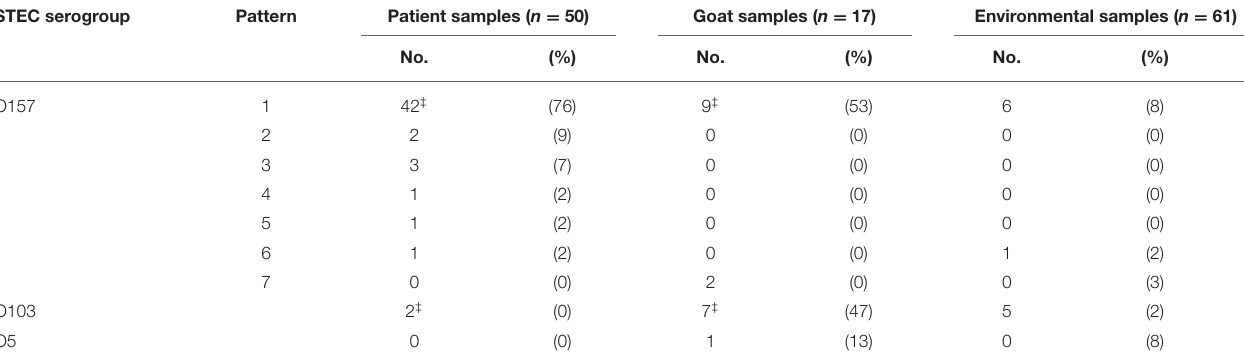
TABLE 3 | E. coli serogroup and pulsed-field gel electrophoresis (PFGE) pattern by isolation source during an illness outbreak linked to visiting farm X—Connecticut, 2016. STEC